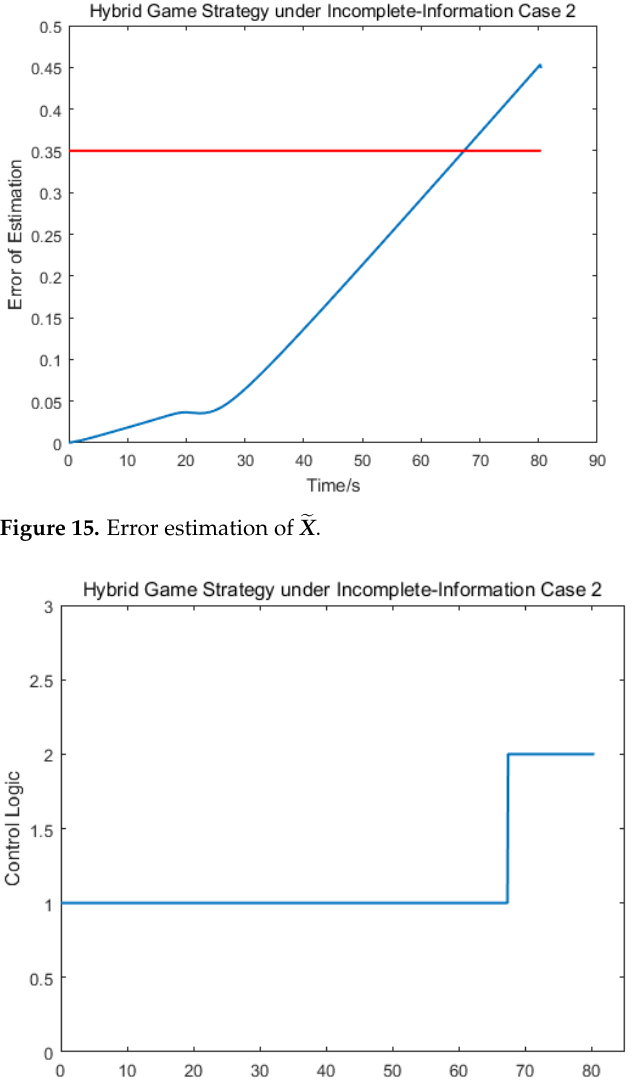
Figure 14. Error estimation of